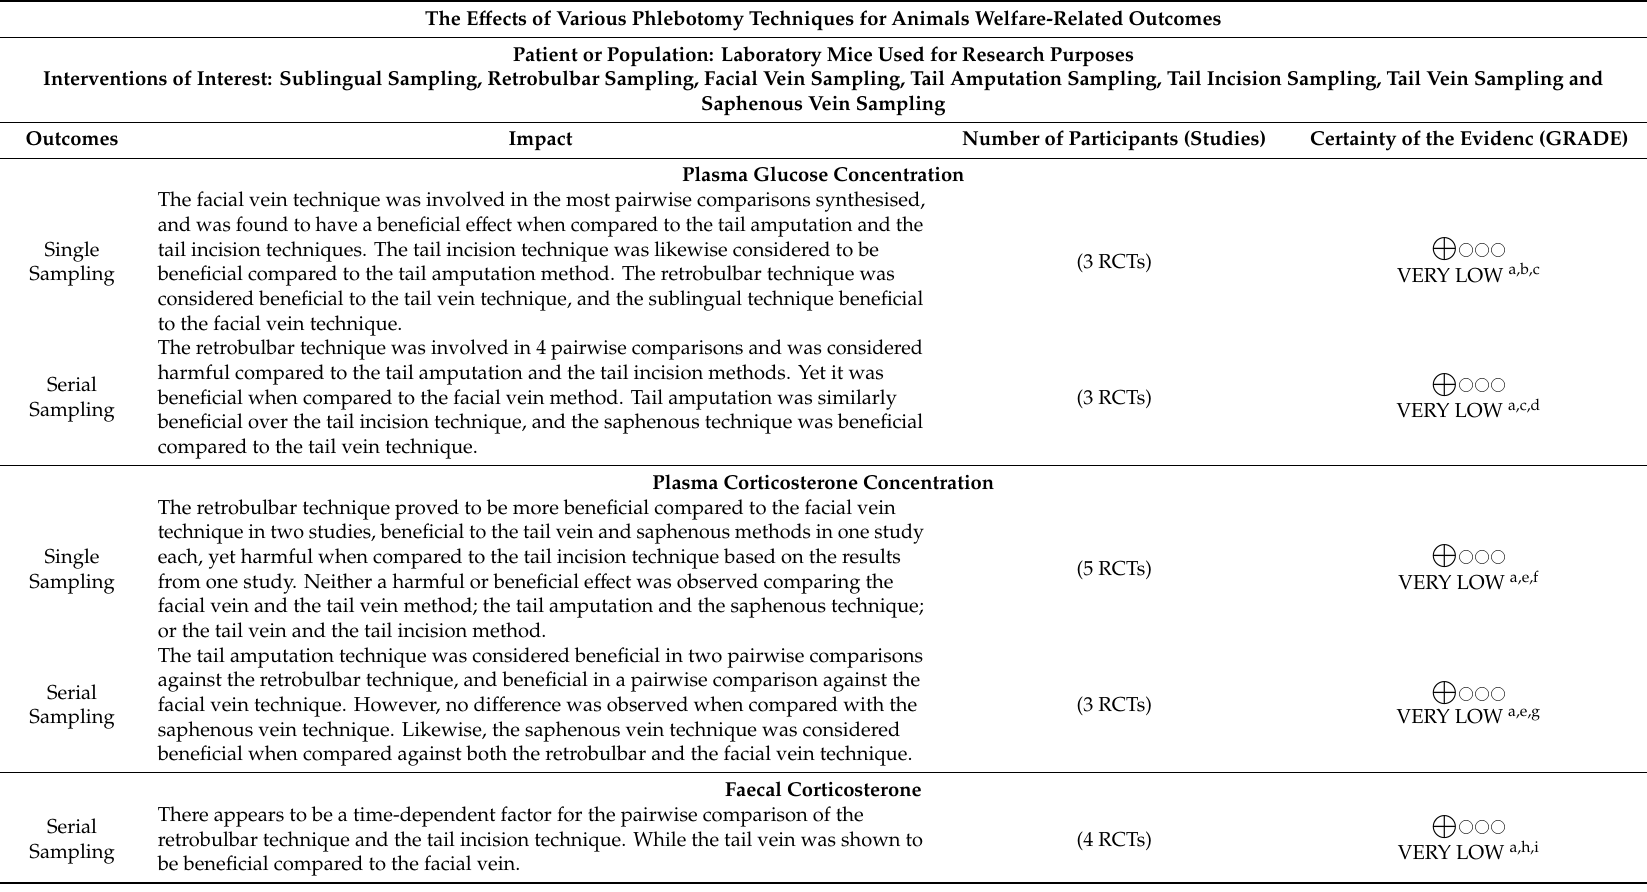
Table 1. Grading of Recommendations, Assessment, Development and Evaluation (GRADE) Summary of Findings table for primary outcomes. The E ff ects of Various Phlebotomy Techniques for Animals Welfare-Related